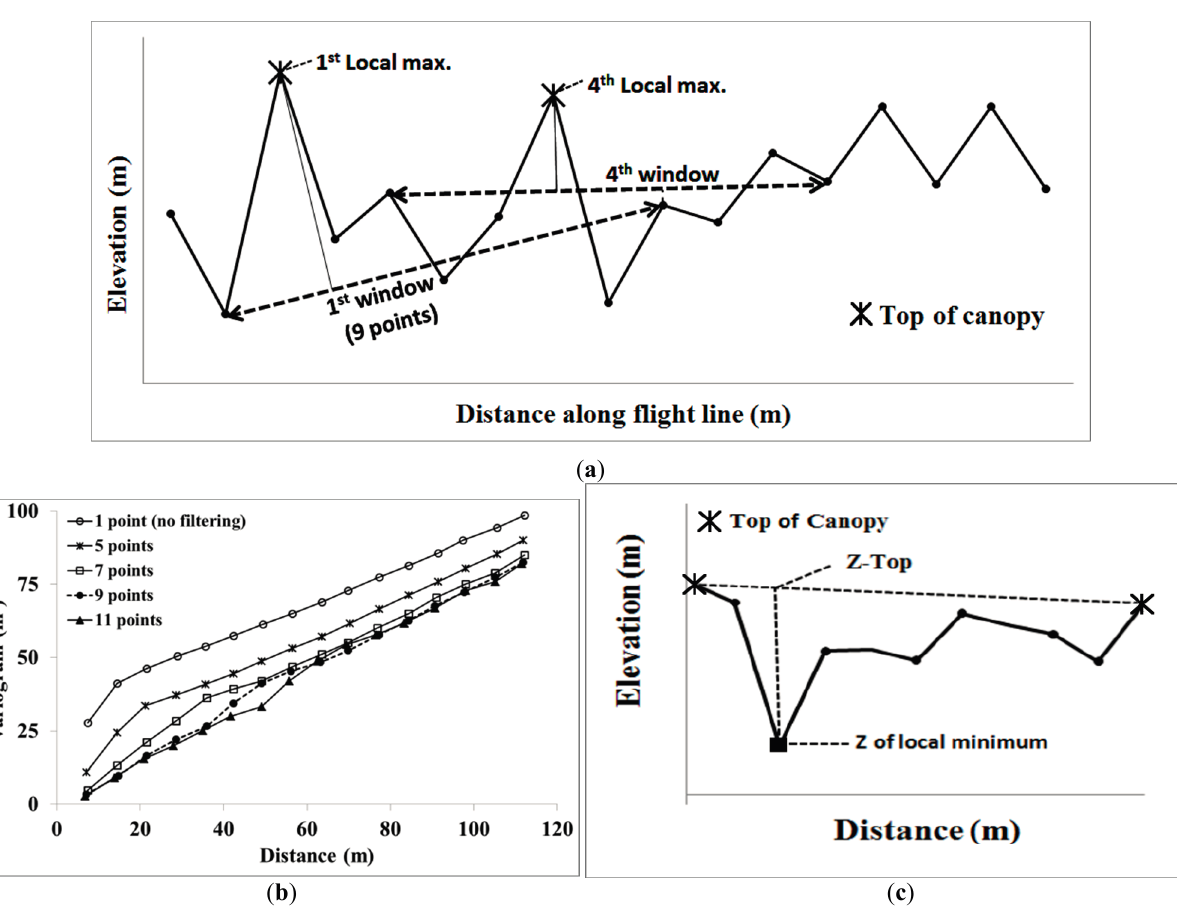
Figure 3. ( a ) Points selected as top of canopy (local maximum); ( b ) Variogram of airborne LiDAR elevations from the LD dataset with local maximum points as a function of the size of the filtering window; ( c ) Canopy height calculation; ( d ) Ground points selected from a 1000-m